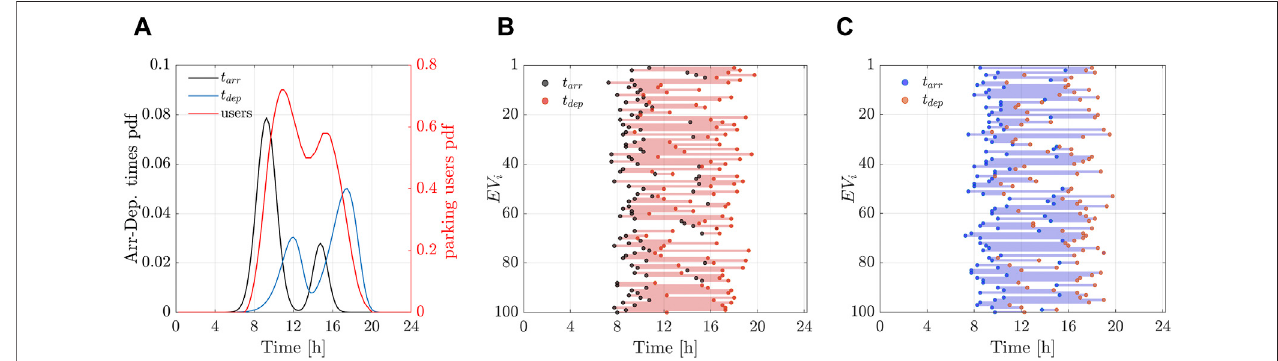
FIGURE 2 | (A) Probability distribution function (pdf) of arrival (black line) and departure (blue line) times together with parking lot user ’ s distribution (red line) during the 24 h. (B,C) Two consecutive days ’ set of arrival and departure